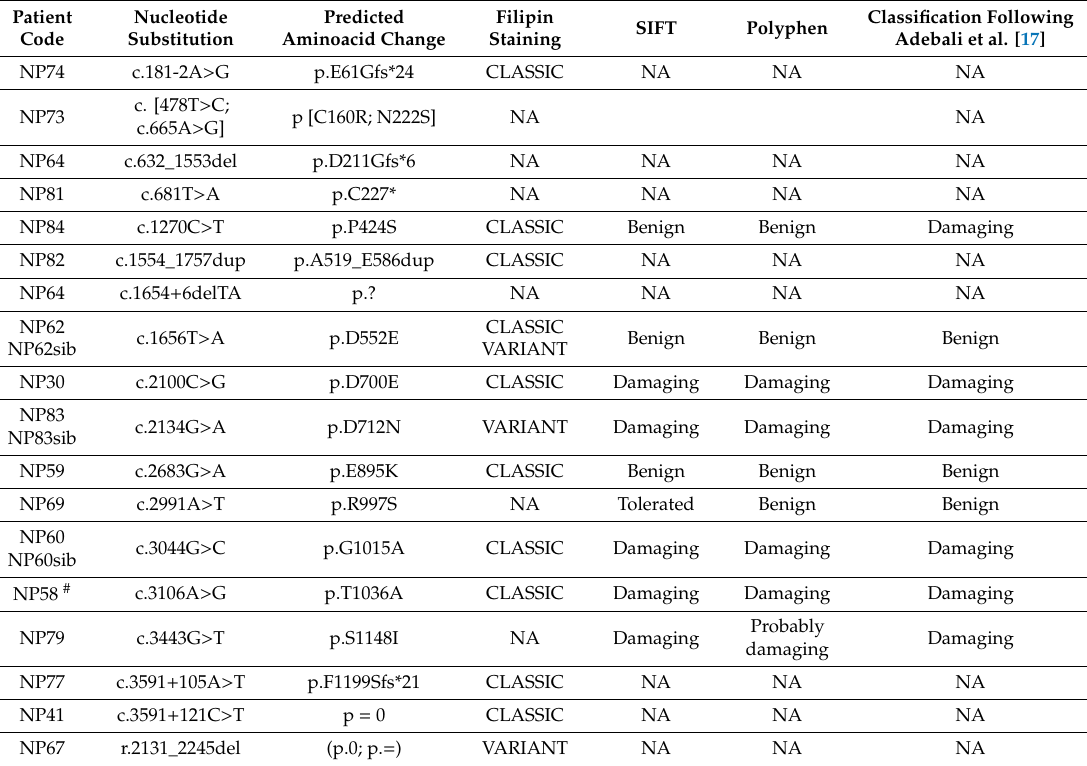
Table 3. Clinical, biochemical, and molecular characteristics of the identified NPC1 novel mutations. Patient Code